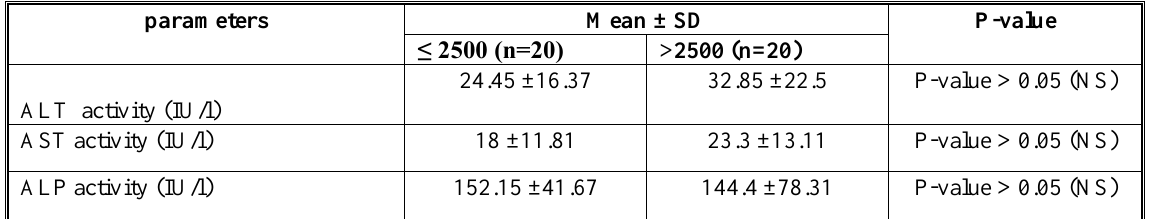
Table6. Effect of Ferritin levels on Serum ALT, AST and ALP in Group